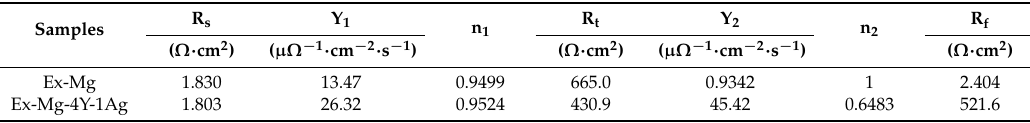
Table 3. Electrochemical parameters of Mg and Ex-Mg-4Y-1Ag alloy from the electrochemical impedance